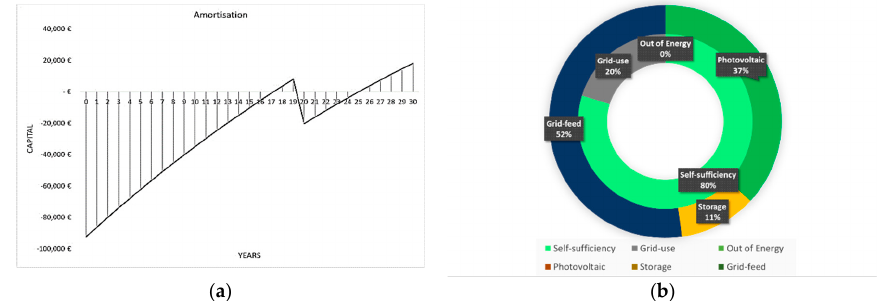
Figure 18. Grid-connected, 20 kWh battery storage, 32.75 kWp, 34 km daily driven distances: ( a ) lifetime payback graph, ( b ) energy balance.